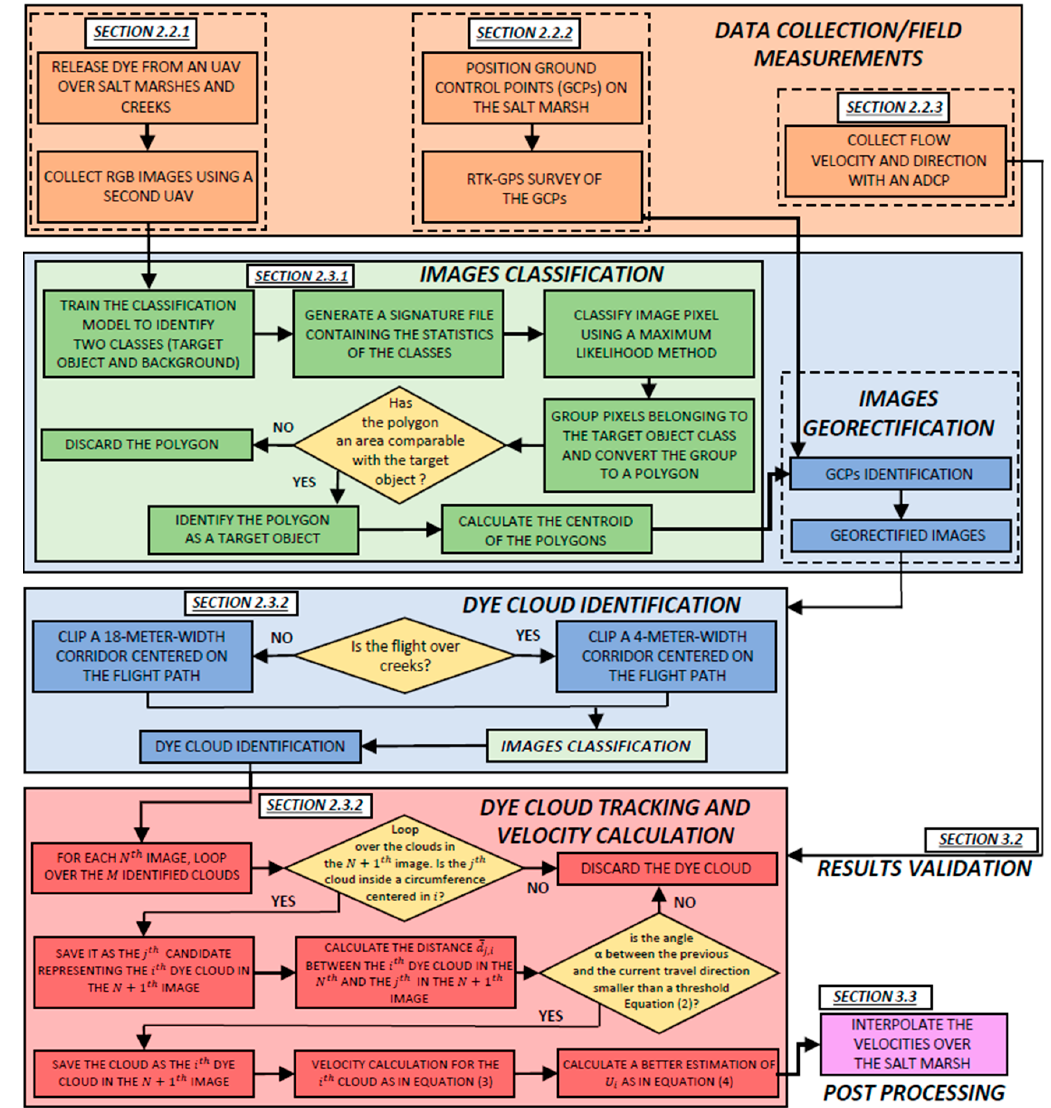
Figure 2. Flowchart describing the procedure used in our study to calculate surface water velocity from UAV-released dye clouds. The main passages of the procedure are indicated in the colored boxes using a larger, bold and italic font type, and the related sections are described in the white filled boxes, using a bold, underlined and italic font type. The colored squares indicate different steps of the procedure: orange filled boxes indicate data collection steps; blue filled boxes indicate pre-processing and data analysis steps; green boxes indicate image classification steps, considered as a pre-processing macro-step; red boxes indicate result generation steps; and purple boxes indicate post-processing steps. The yellow diamond indicates decision steps. The reads should refer to the indicated sections for a broader description of the